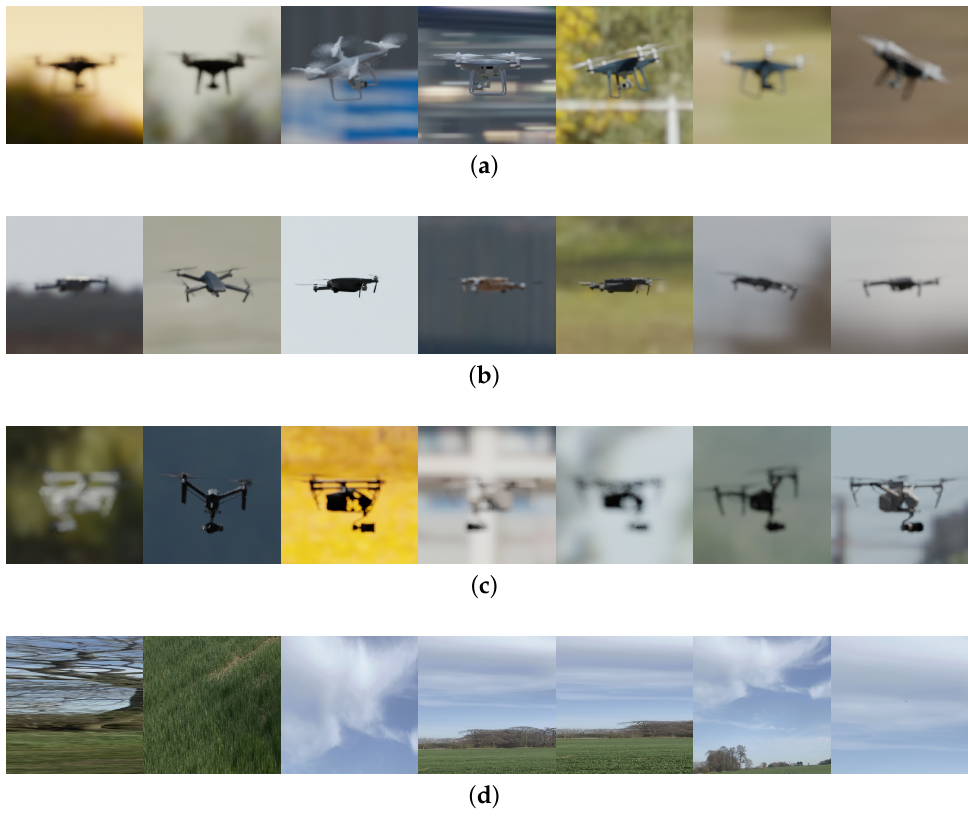
Figure 2. The synthetic drone images with all of the randomizations enabled, generated by the simulation in Blender, used for training and validation of the convolutional neural network (CNN). The images are intended to cover a large number of potential scenarios, with different background and lighting conditions. The camera parameters such as the focal length and focus point are also randomized to make the dataset as photorealistic as possible. The textures of the drones are also randomized with the aim of training the CNN to detect the shape, instead of the colour of the drone. Thus, the colour of the drones appears different in some of the images even for the same drone models. ( a ) DJI Phantom, ( b ) DJI Mavic, ( c ) DJI Inspire and ( d ) No